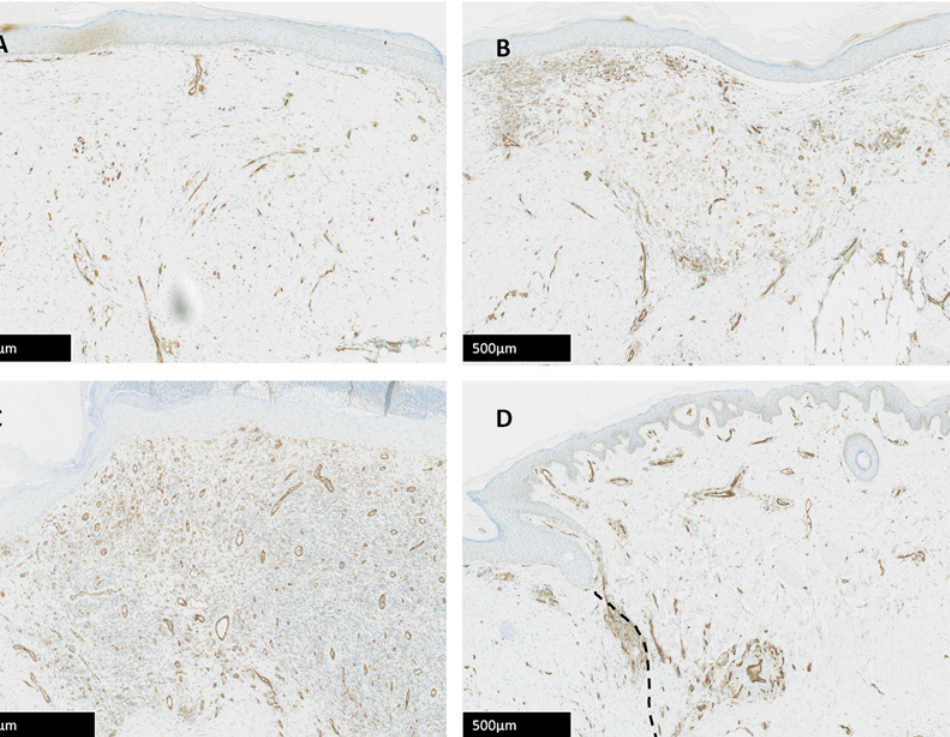
Figure 8. Immunohistochemical evaluation. Visualisation of time-matched (all d28) differences in CD31 expression between treatment groups in the same subject demonstrating significantly greater expression in the DCD treated wound. CD31 stain quantification assessed with Definiens Tissue Studio software and expressed as average vessel number/section. A — Control, B — CG, C — DCD, D — Autograft. Black dotted line — demarcates boundary between autograft and native